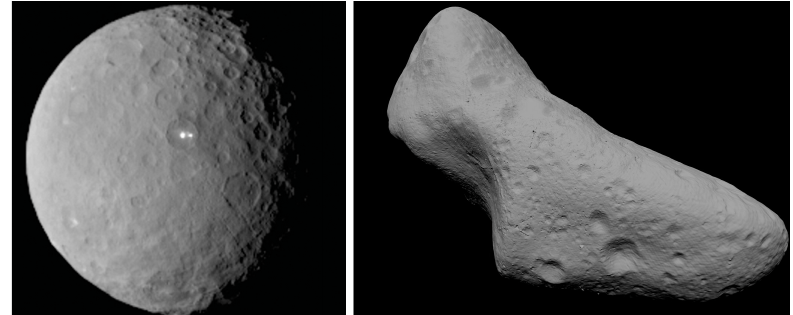
Fig. 2. Ceres (an image taken by the Dawn spacecraft on February 15, 2015) and Eros (Credit & Copyright: NEAR Project, NLR, JHUAPL, Goddard SVS,